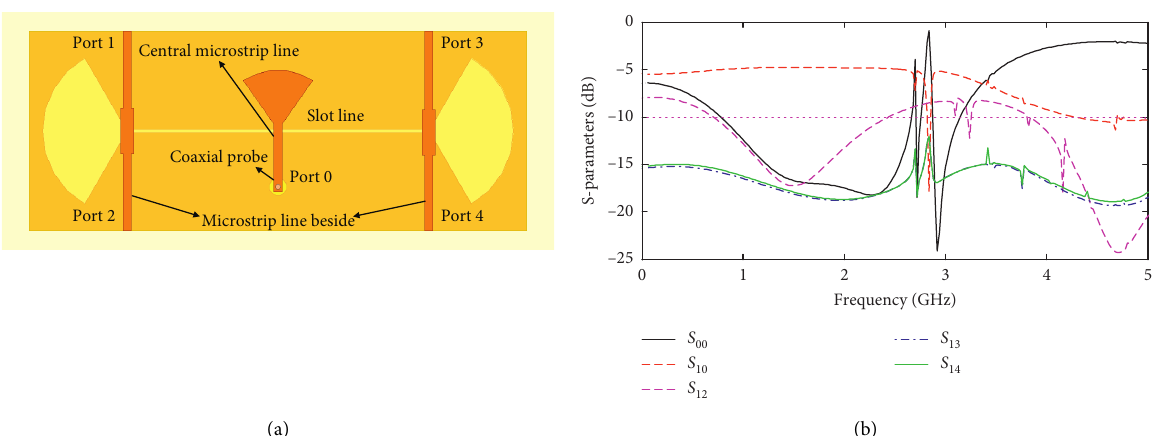
Figure 4: (a) Structure of the proposed feeding network. (b) The transmission ( S ports ( S 12 , S 13 , and S 14 ) of the proposed